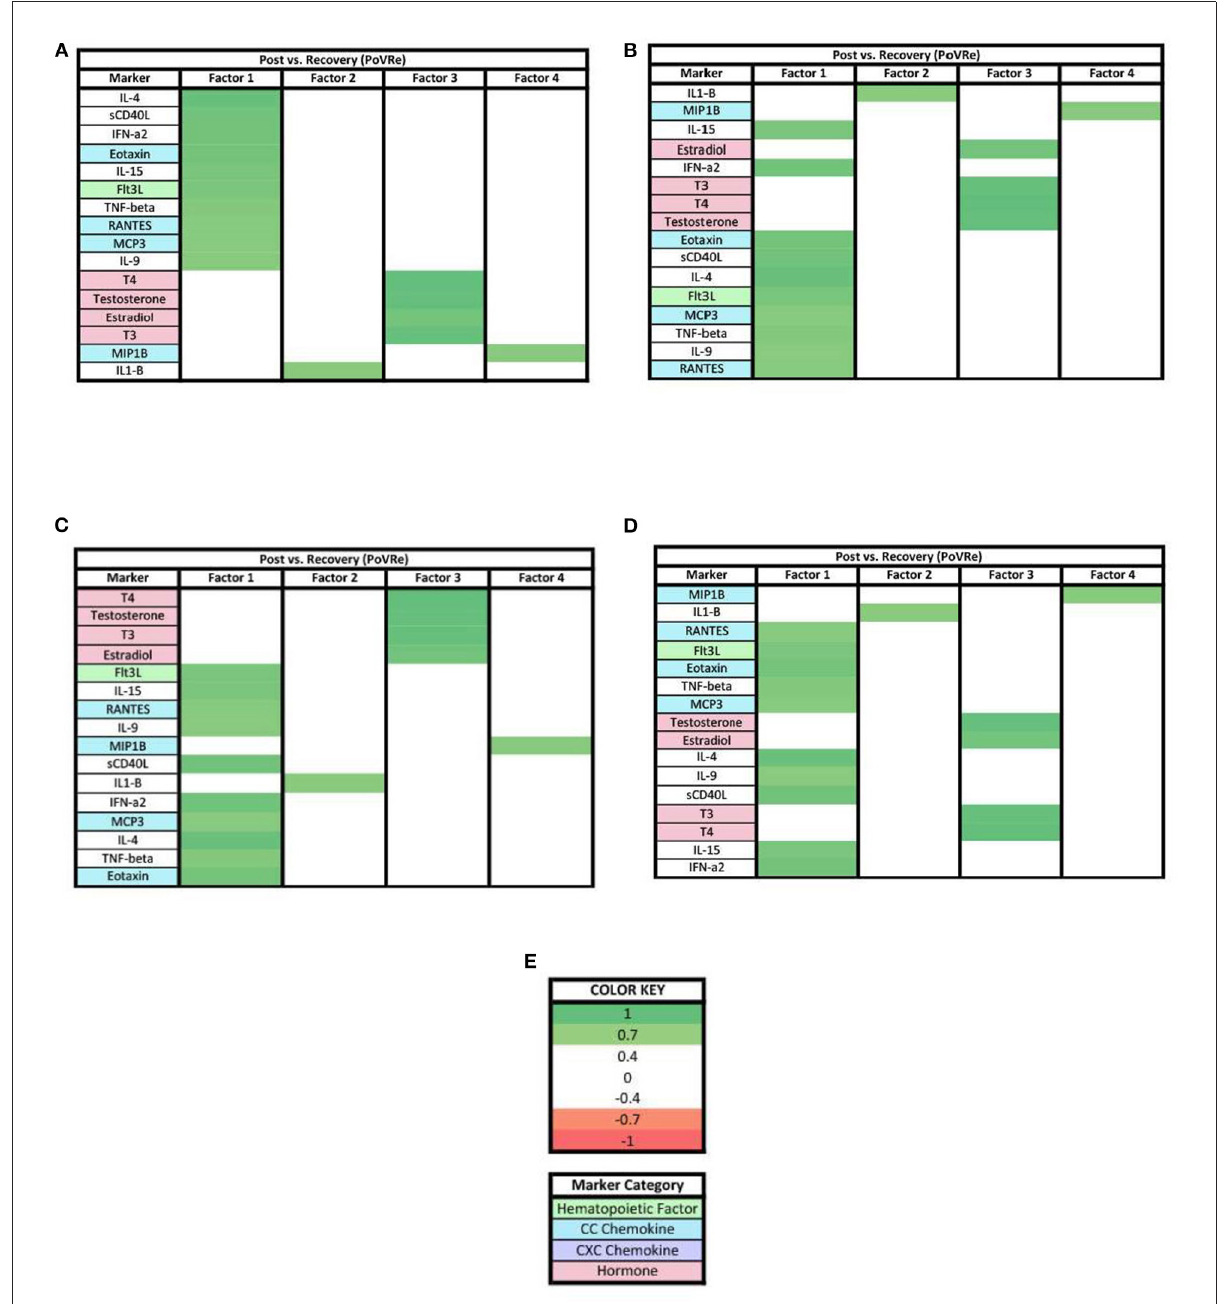
FIGURE6 Heat maps of the post-stress vs. recovery (PoVRe) analysis of loadings ≥ 0.7. (A) Biomarkers sorted from highest to lowest loading in PoVRe factor 1. (B) Biomarkers sorted from highest to lowest loading in PoVRe factor 2. (C) Biomarkers sorted from highest to lowest loading in PoVRe factor 3. (D) Biomarkers sorted from highest to lowest loading in PoVRe factor 4. (E) Color key for PoVRe loadings ≥ 0.7, sorted top to bottom from most positive to most negative.